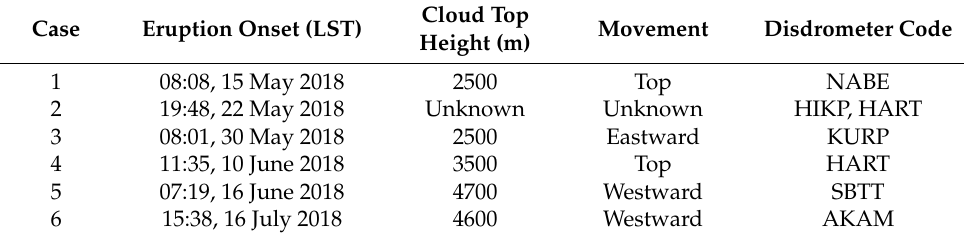
Figure 2. The network of 13 Parsivel 2 instruments installed on Sakurajima to measure volcanic ash particle size distribution (PSD). Triangle indicates the southern summit (Minami-dake); square indicates the position of X-band multi-parameter radar (XMP). Table 2. List of Sakurajima volcanic eruptions analyzed in the present